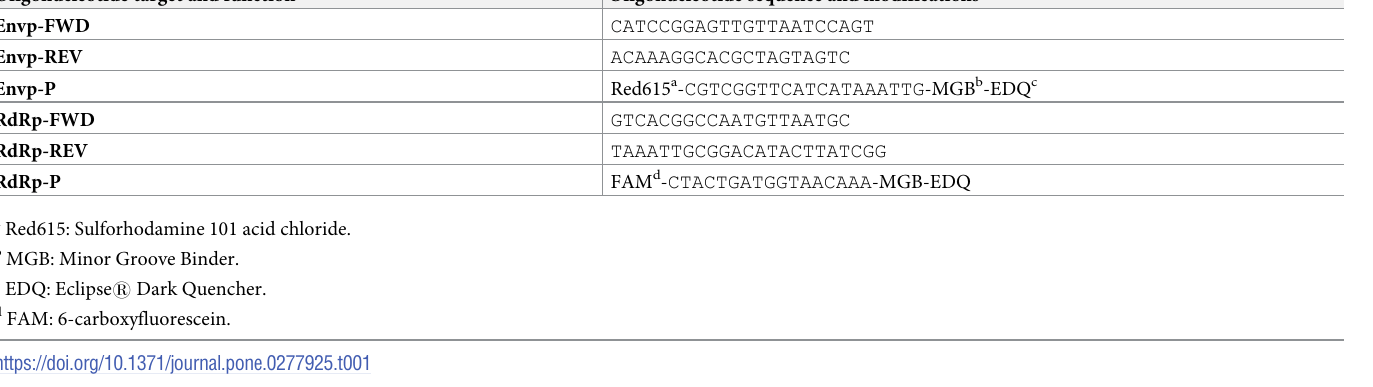
Table 1. Oligonucleotides used in GenomEra SARS-CoV-2 assay kit. Oligonucleotide target and